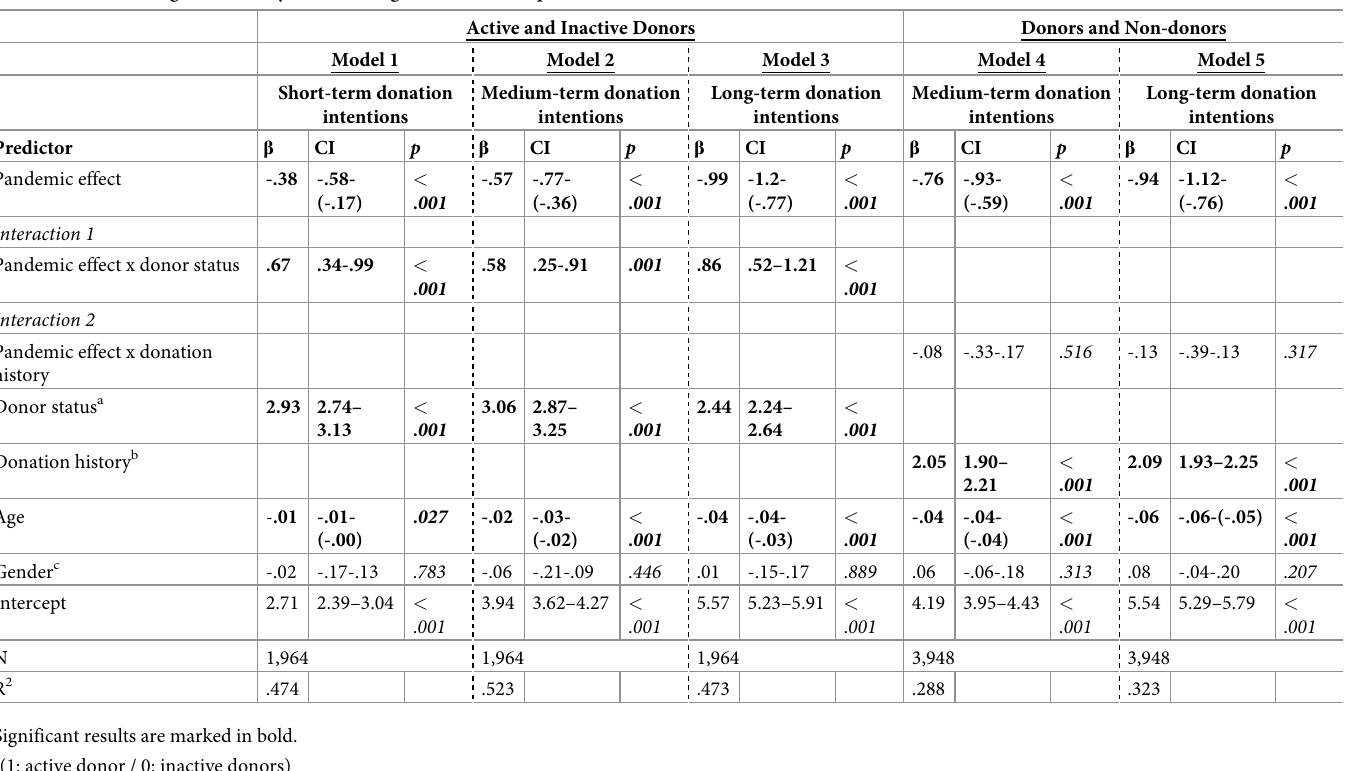
Table 1. Results of regression analysis measuring the effect of the